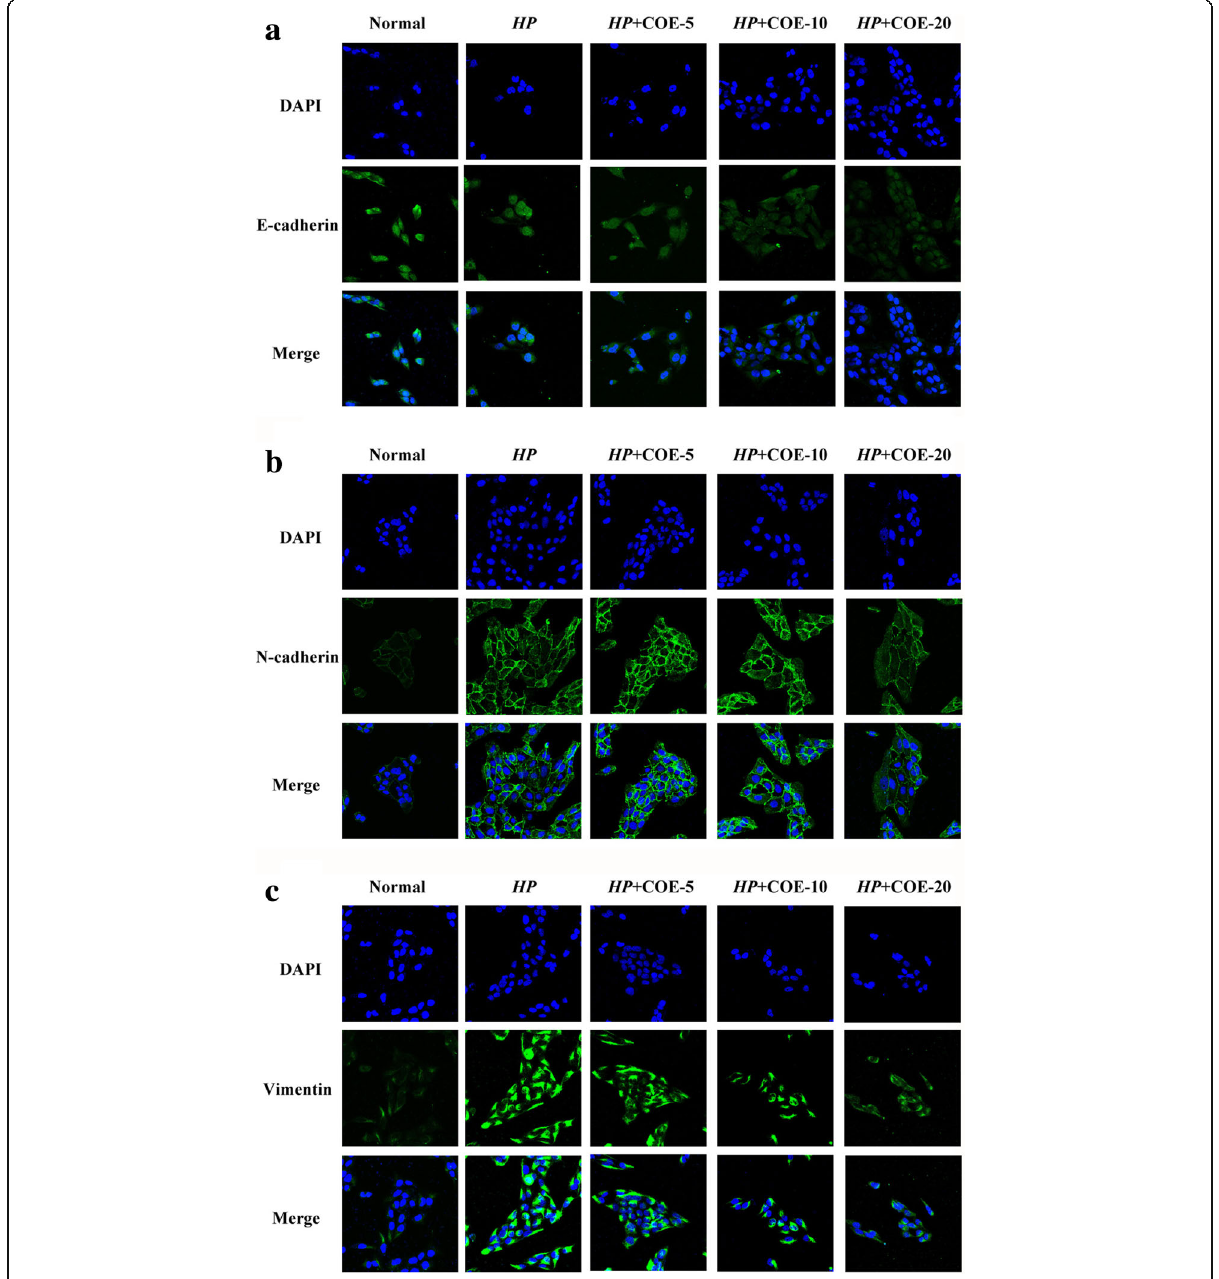
Fig. 3 Immunofluorescence microscopy analysis of the localization and expression of EMT-related gene in H. pylori infection-induced GES-1 cells treated with or without COE. Representative pictures of cells were obtained under a microscope at × 400